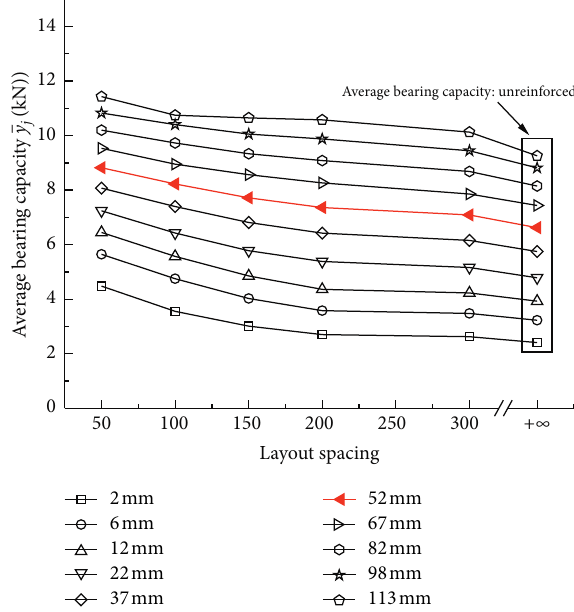
Figure 10: Influence of different spacing on bearing